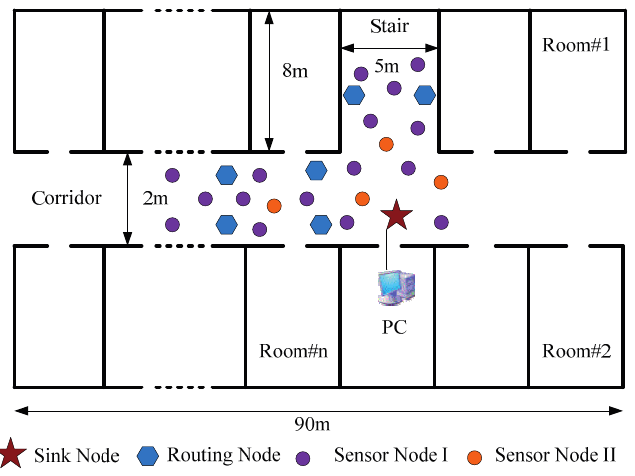
Figure 4. Testing in the laboratory